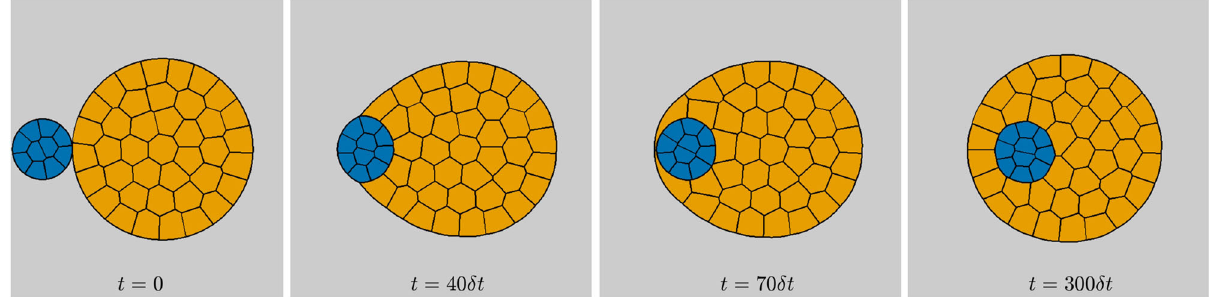
Fig. 2 Total engulfment via level set-based model. An initial aggregate of 10 blue and 40 orange cells surrounded by a gray medium and snapshots of its evolution generated by our level set-based method, resulting in total engulfment of the blue cell mass by the orange cell mass. Here the interfacial tensions are σ BB = σ OO = 1.0, σ BG = 7.5, σ OG = 3.5, and σ BO linearly changing from 7.5 at time t = 0 to 2.5 at time t = 100 δ t and then kept